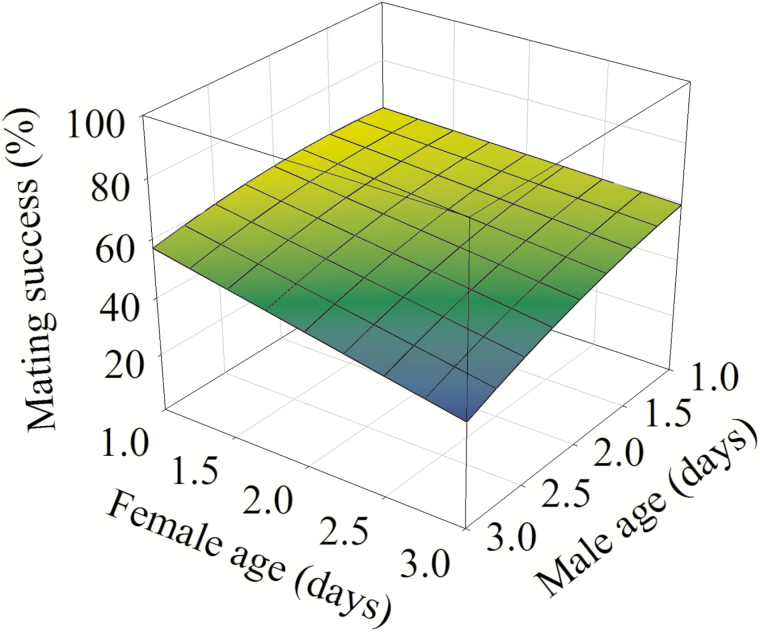
Effect of female and male age on mating success in P. ﬂammans. Mating success (%) = 60.00 + 10.31 × male age—2.78 × male age2 – 3.21 × male age × female age (F = 146.68; df = 3, 5; P < 0.001; R2 = 0.989).